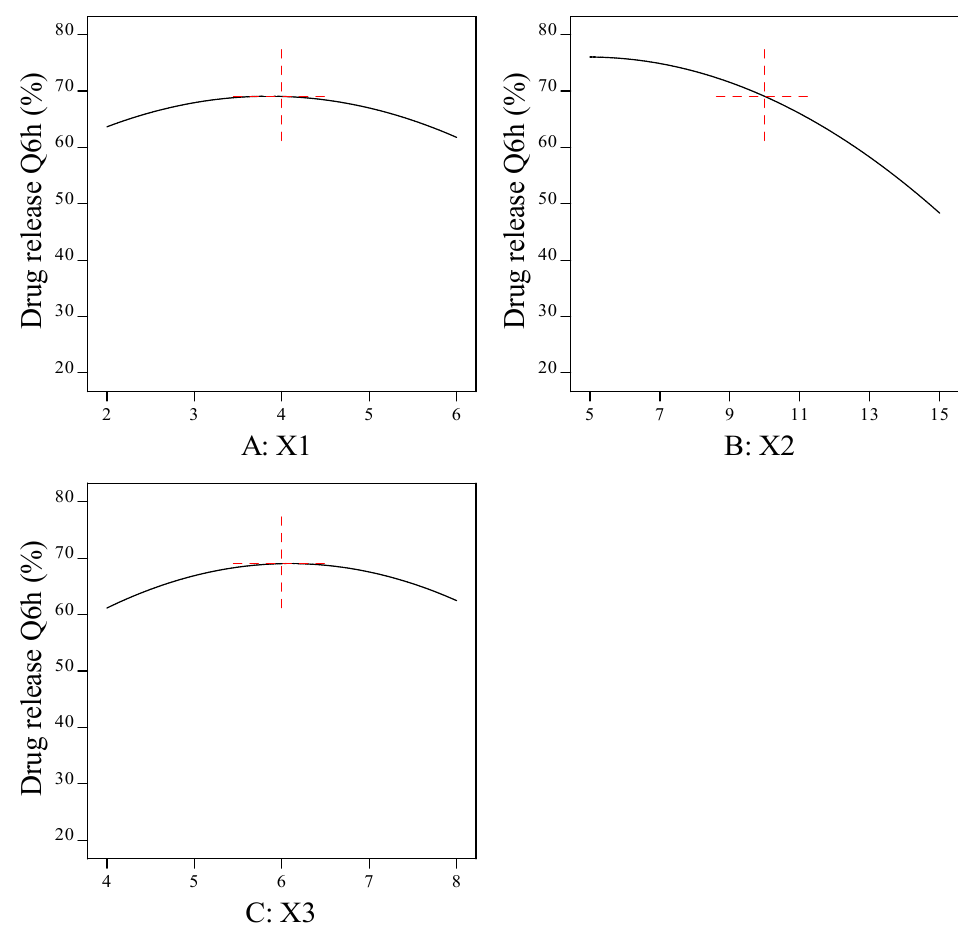
Figure 7. Main-effect plot for the effect of formulation factors (X1, X2, and X3) on the in vitro drug release Q6h (Y3). ( A ) Effect of sodium alginate concentration on the in vitro drug release Q6h (Y3); ( B ) effect of cross-linker concentration on the in vitro drug release Q6h (Y3); and ( C ) effect of sesame oil concentration on the in vitro drug release Q6h (Y3).